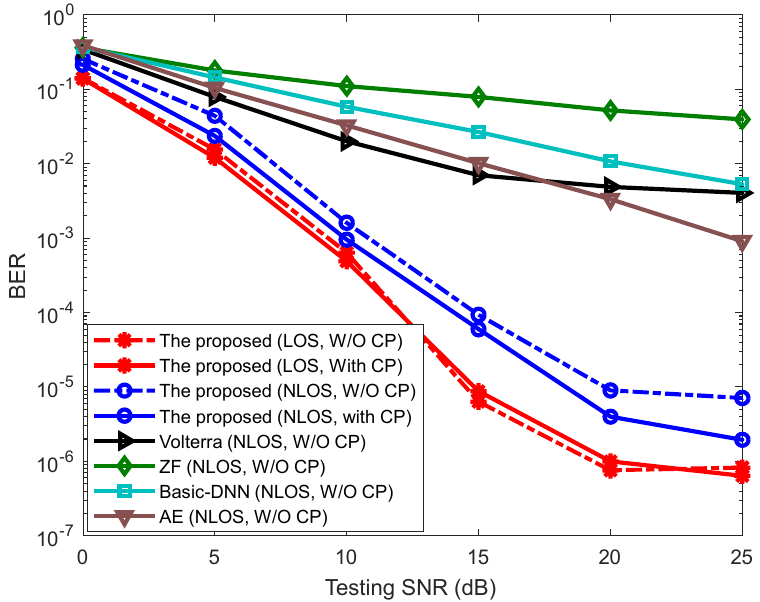
Figure 9. BER performance of the proposed scheme with/without CP.